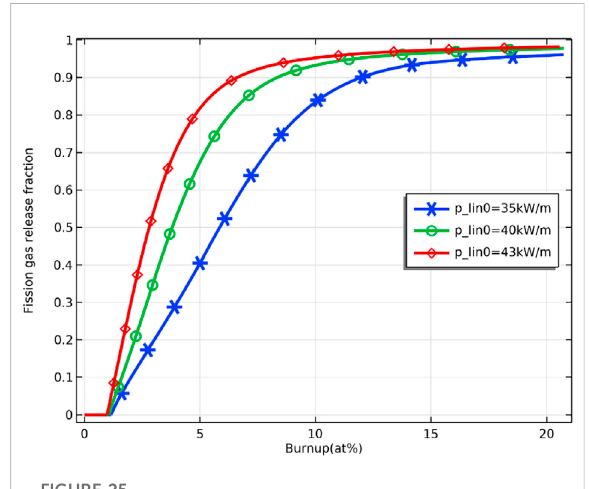
FIGURE 24 Gap closure process for initial linear power of 35 kW/m, 40 kW/m and 43 kW/m.